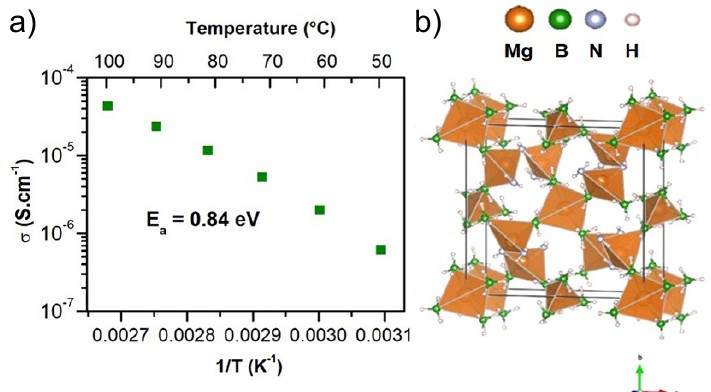
Figure 2. Adapted with permission from reference [161]. Copywrite 2020. American Chemical Society. ( a ) Temperature dependent conductivity for Mg 3 (BH 4 ) 4 (NH 2 ) 2 . ( b ) Crystal structure of Mg 3 (BH 4 ) 4 (NH 2 ) 2